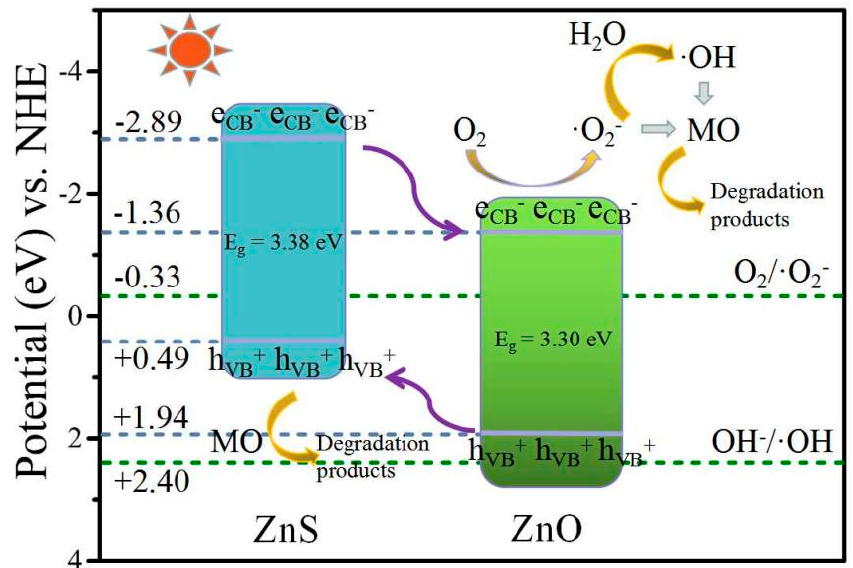
Figure 10. Photocatalytic mechanism of degradation MO over the ZnO/ZnS photocatalyst.